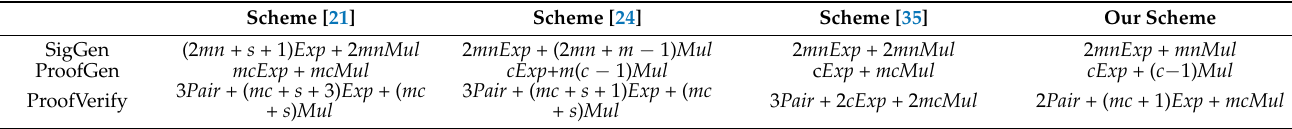
Table 3. Computational overhead